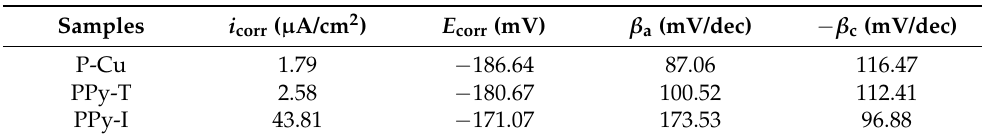
Table 2. Kinetic parameters from potentiodynamic polarization for uncoated and coated copper